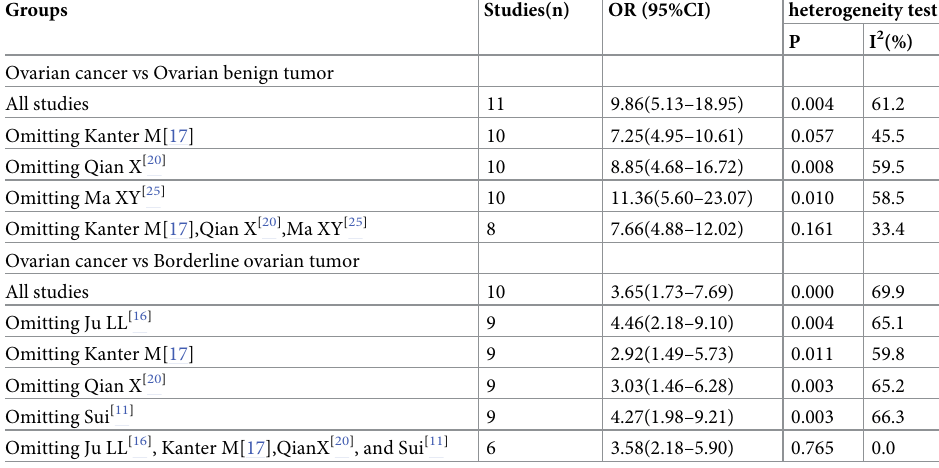
Table 2. Sensitivity